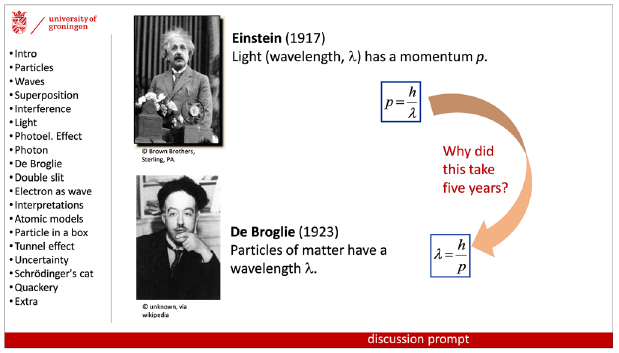
FIG. 2. Example of a slide with a discussion